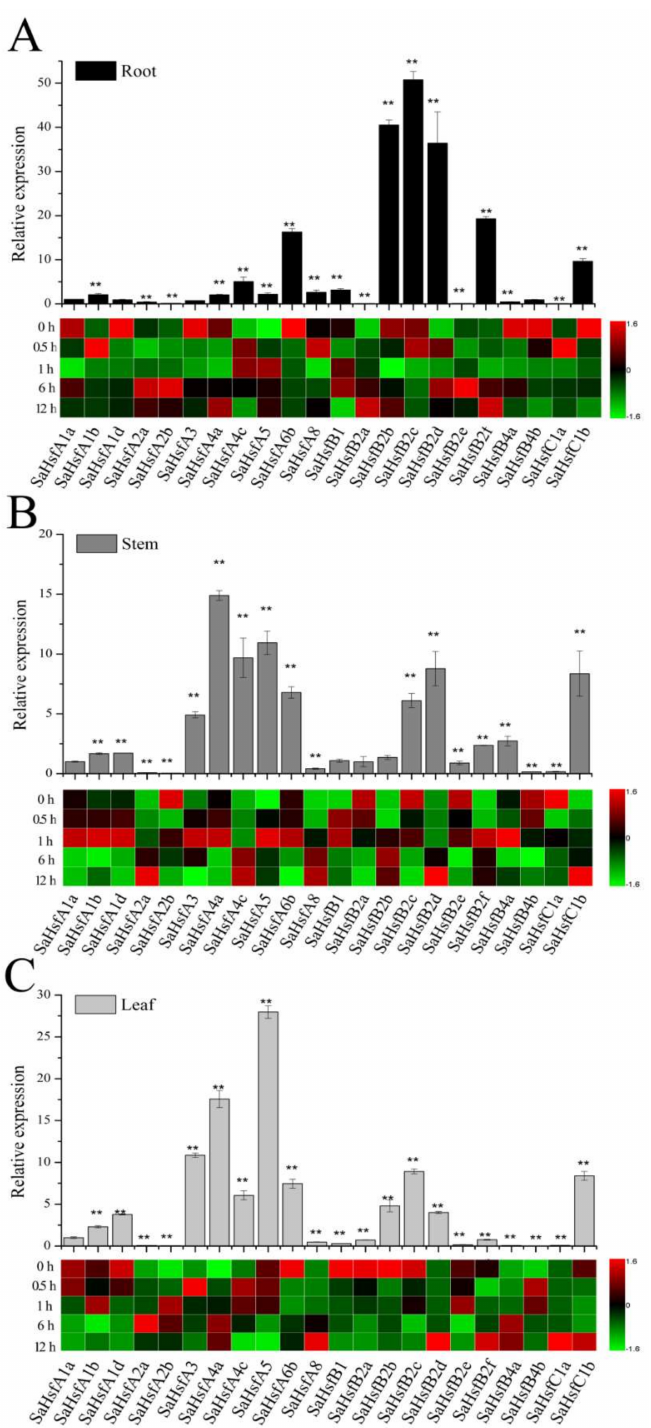
Figure 4. Expression profiles of SaHsfs in different tissues under normal and cadmium (Cd) stress conditions: ( A ) root; ( B ) stem; ( C ) leaf. Column chart and heat map representation for the expression patterns of the 22 SaHsf genes under normal and CdCl 2 treatment, respectively. The normalized mRNA levels of SaHsfA1a (y-axis “Relative mRNA expression”) were set arbitrarily to 1 in the column chart, under normal condition. The normalized mRNA levels without treatment were set arbitrarily to 1 in the heat map. Different colors correspond to log2 transformed values compared with the control (0 h). Green and red represent the low and high level of transcript abundance, respectively. Bars indicate means ± standard deviations (SDs) of at least three independent biological experiments. **— p <